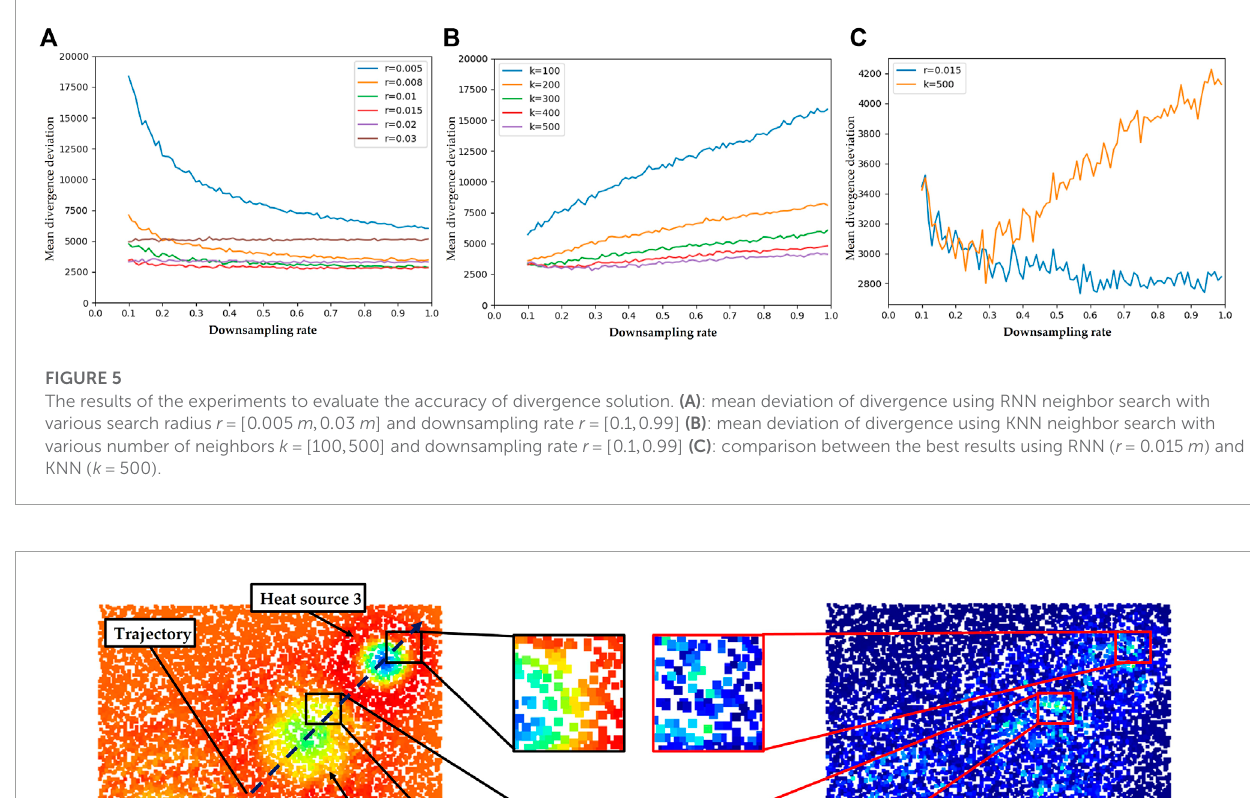
β = ( 0 . 1 , 0 . 99 ) . This downsampling rate is defined